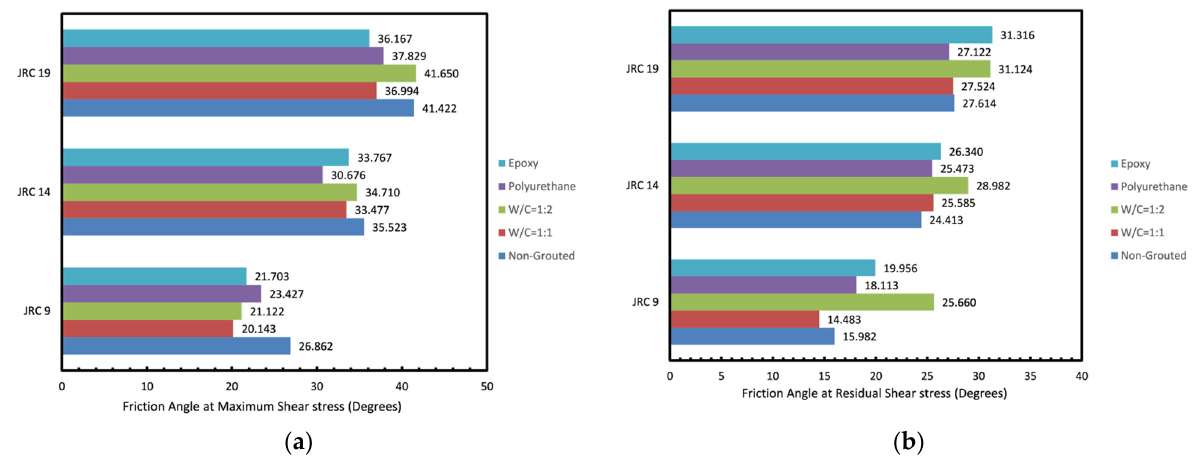
Figure 8. Friction angle at ( a ) maximum shear stress and ( b ) residual shear stress obtained for the rock joints tested.